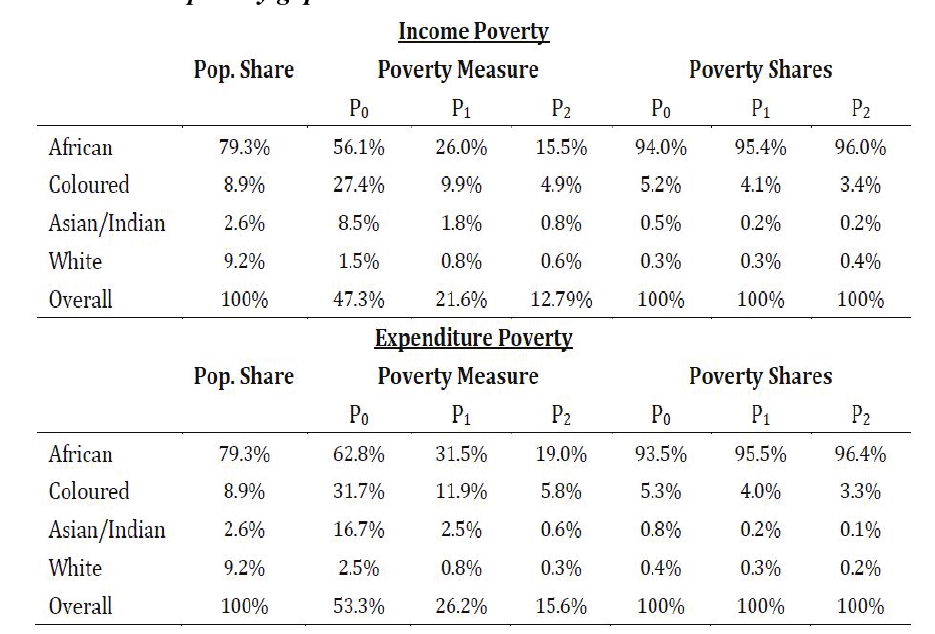
Table 2: Racial poverty